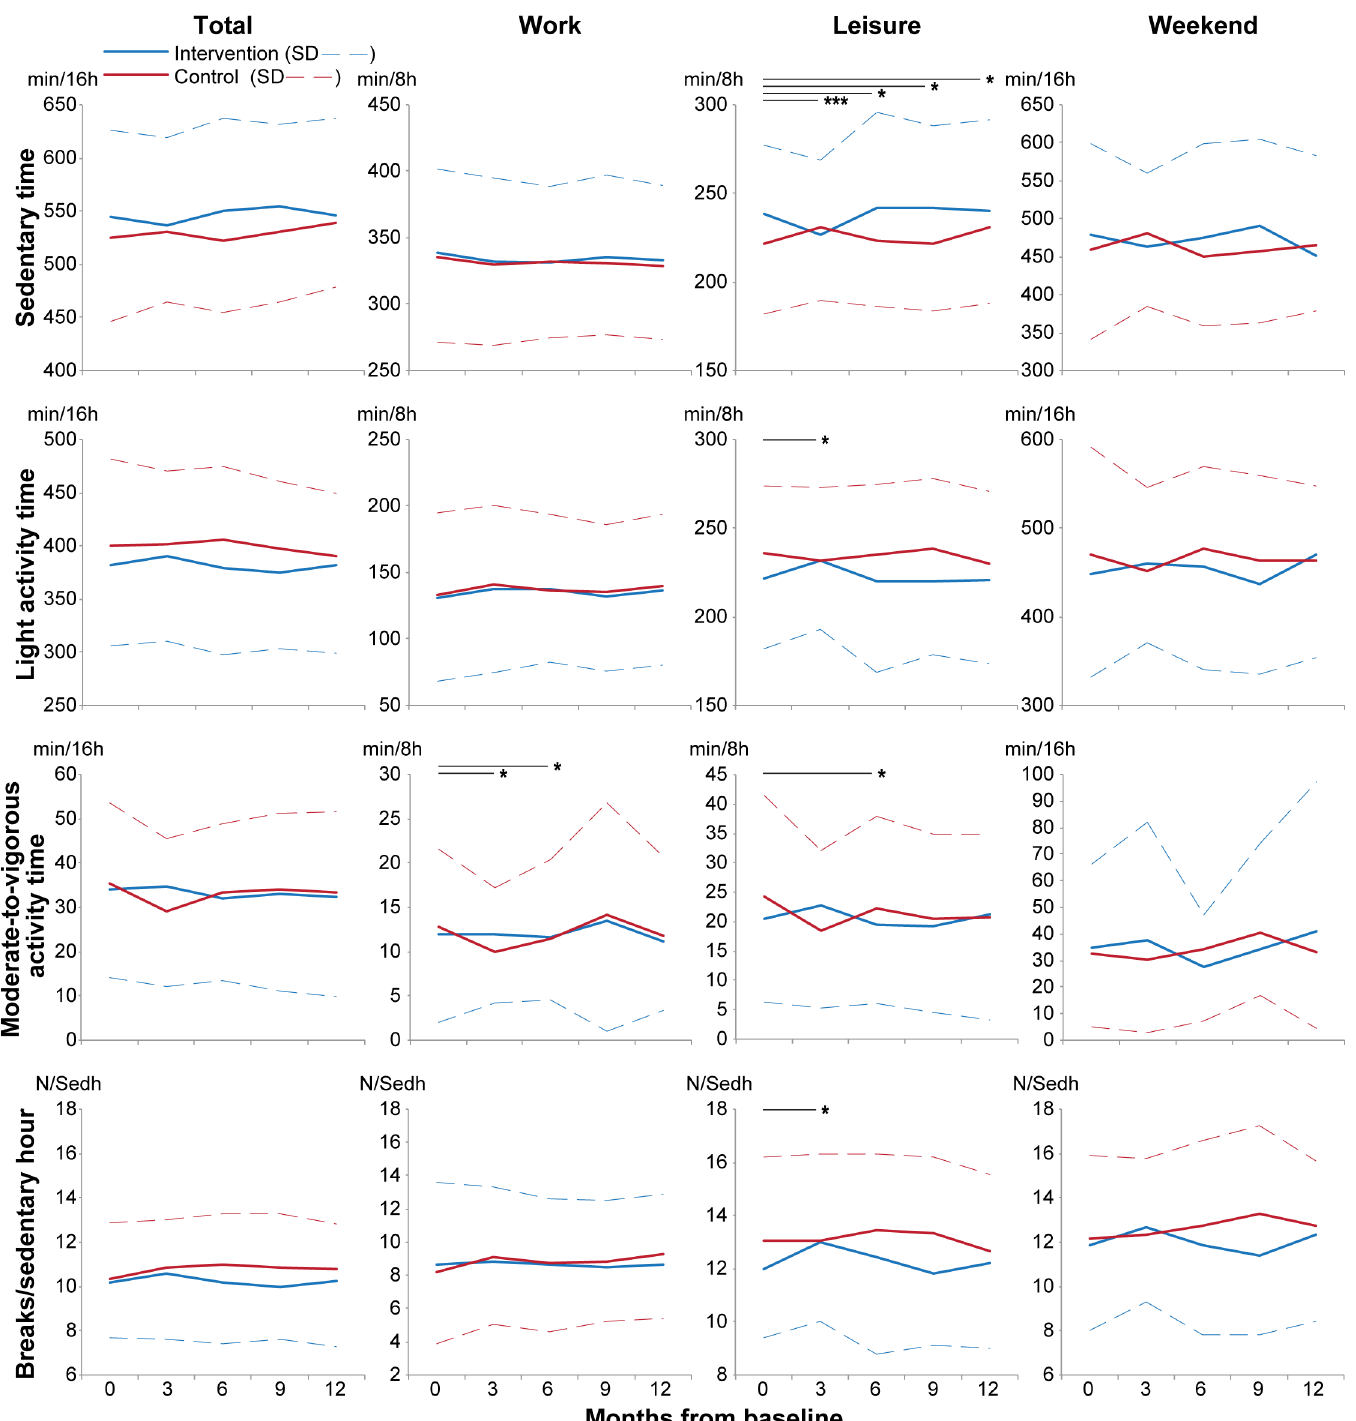
Fig 2. Intervention effectiveness on absolute values of primary outcomes in different domains throughout the study. Means and standard deviations(SD) are presented. Footnote: Significance for likelihoodratios between models with and without group x time interactionat different time periods is illustratedas follows: * = P < 0.05, *** = P < 0.001.